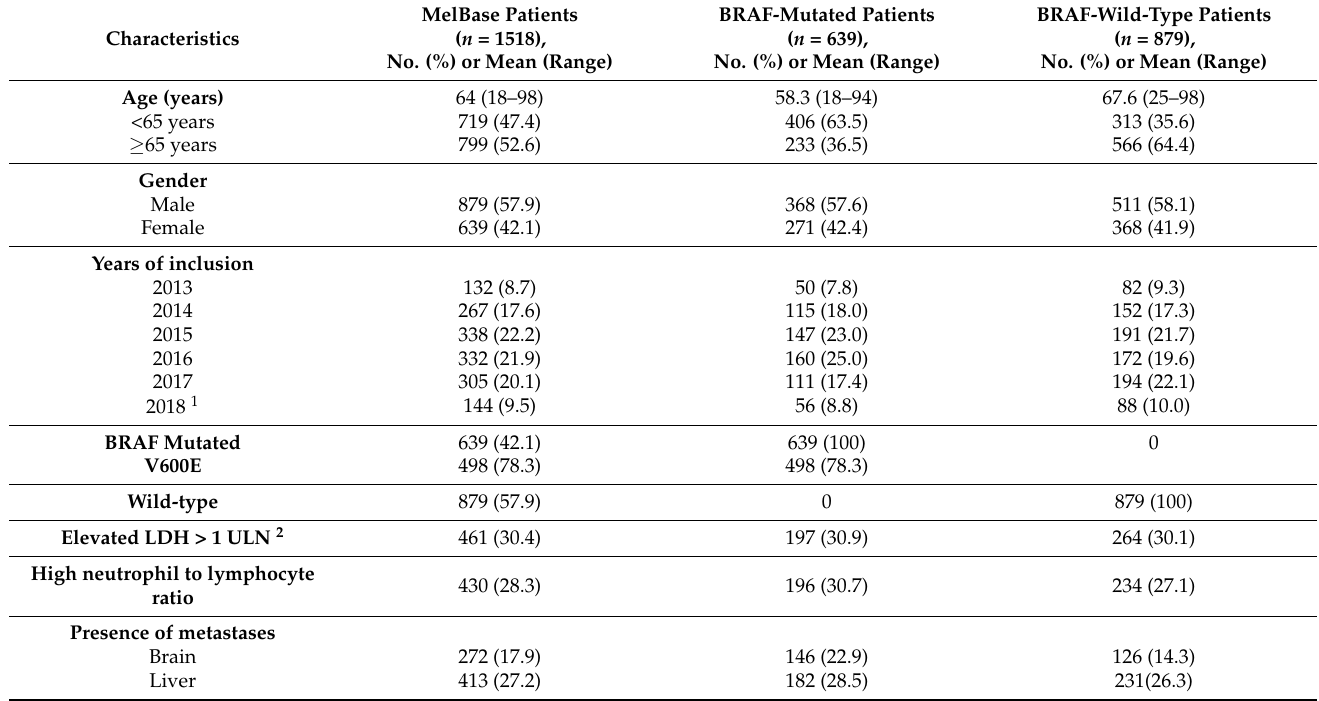
Table 1. Initial characteristics and treatments received by the 1518 patients of the MelBase cohort, for the whole cohort and according to their BRAF